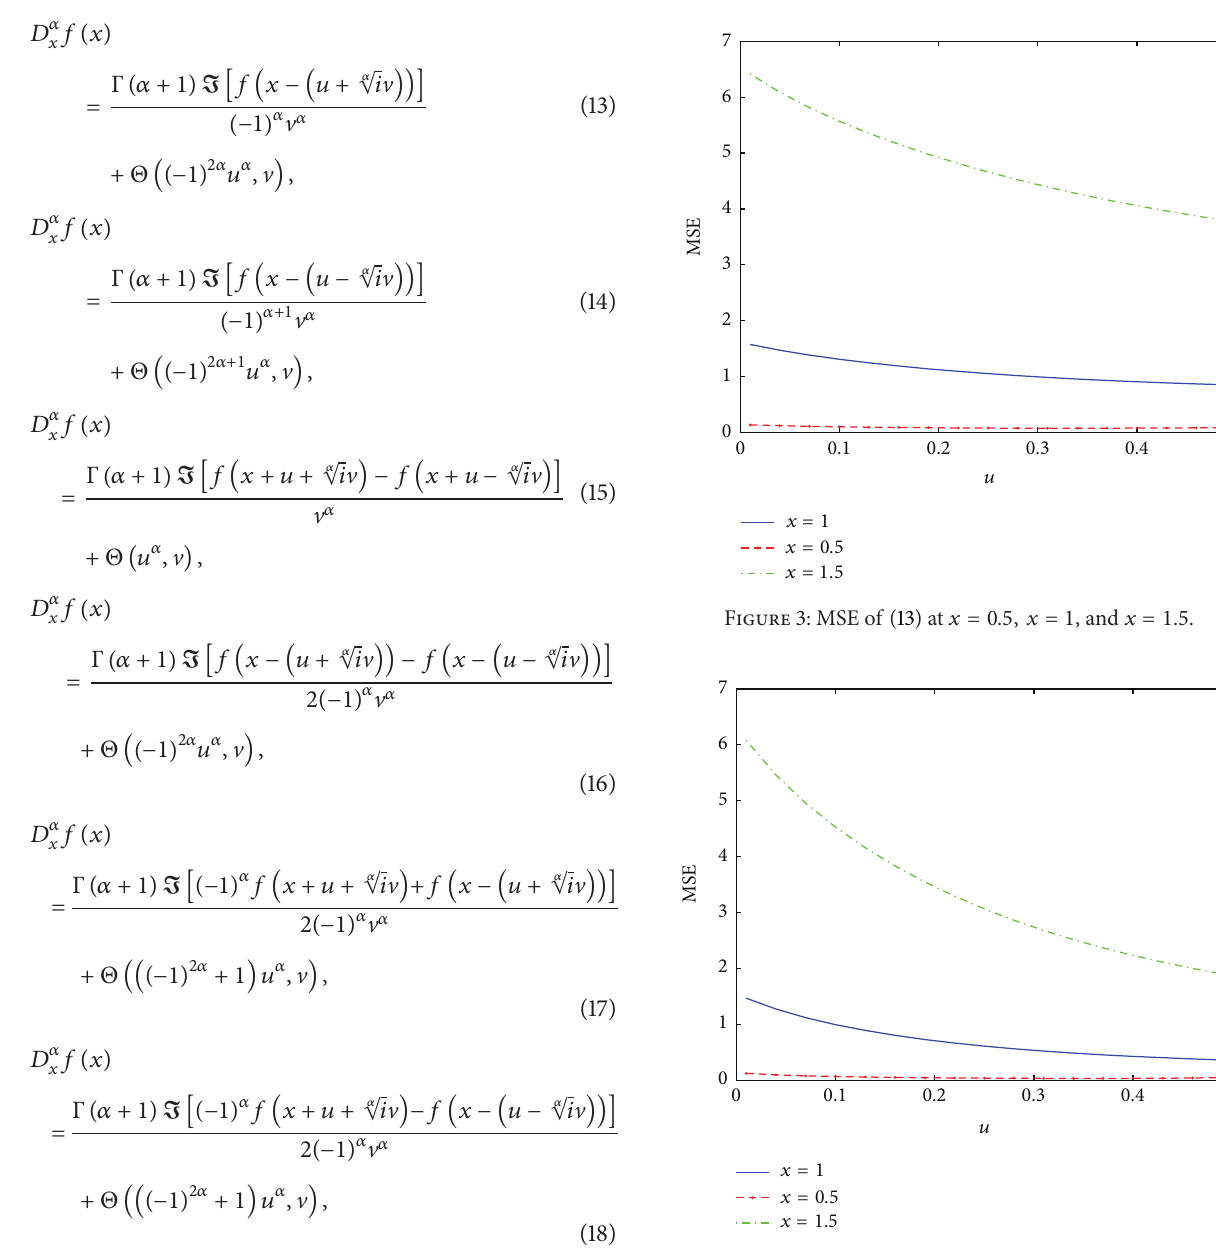
Figure 4: MSE of (14) at 𝑥 = 0.5 , 𝑥 = 1 , and 𝑥 = 1.5